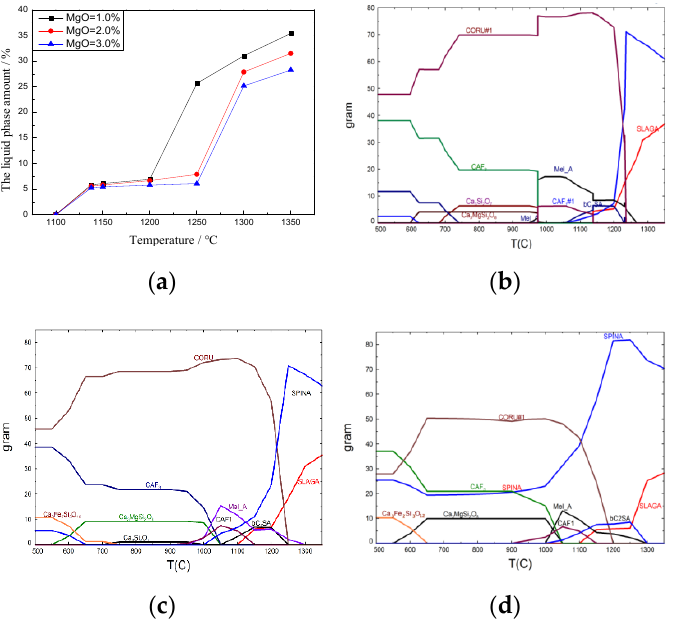
Figure 6. Mineral composition and liquid phase amount with different MgO contents. ( a ) Liquid phase amount of sinter; ( b ) MgO content of 1.0%; ( c ) MgO content of 2.0%; ( d ) MgO content of 3.0%.